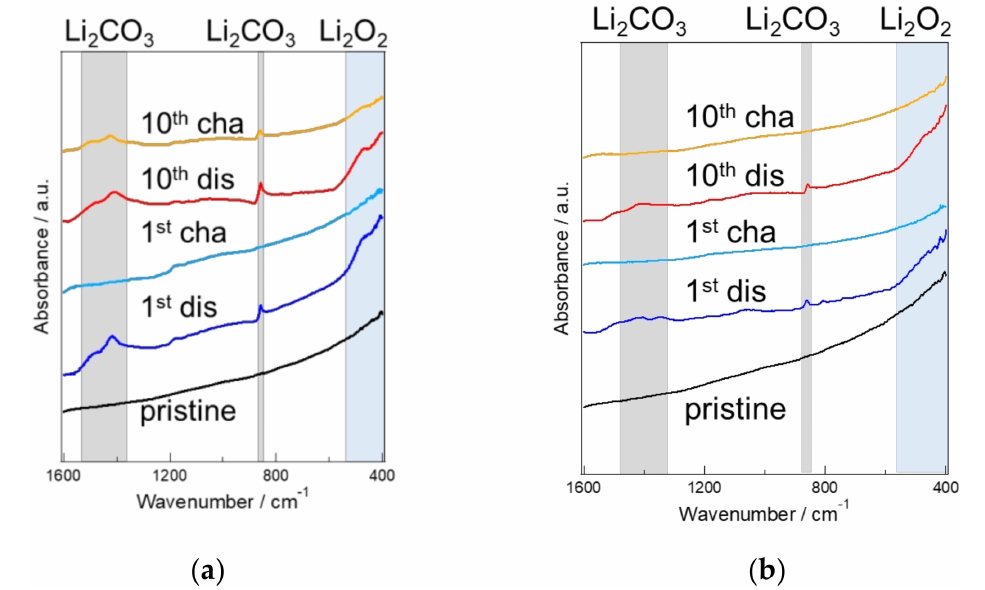
Figure 10. FT-IR spectra of ( a ) KB and ( b ) KB + VUV before and after cycling